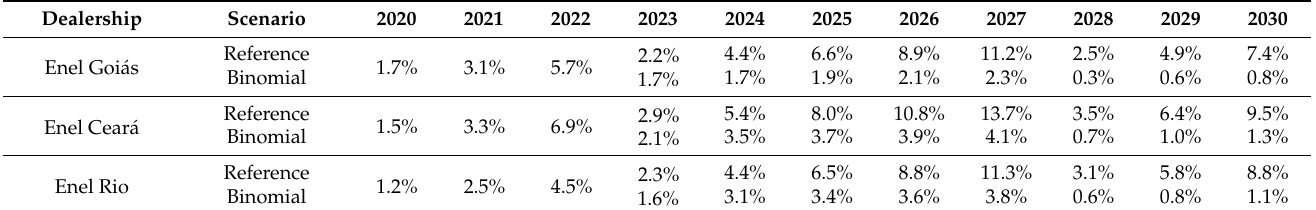
Table 17. The MMDG economic effects estimate on the regulatory revenue of part B (VPB 0) at Enel’s distributors, in %.